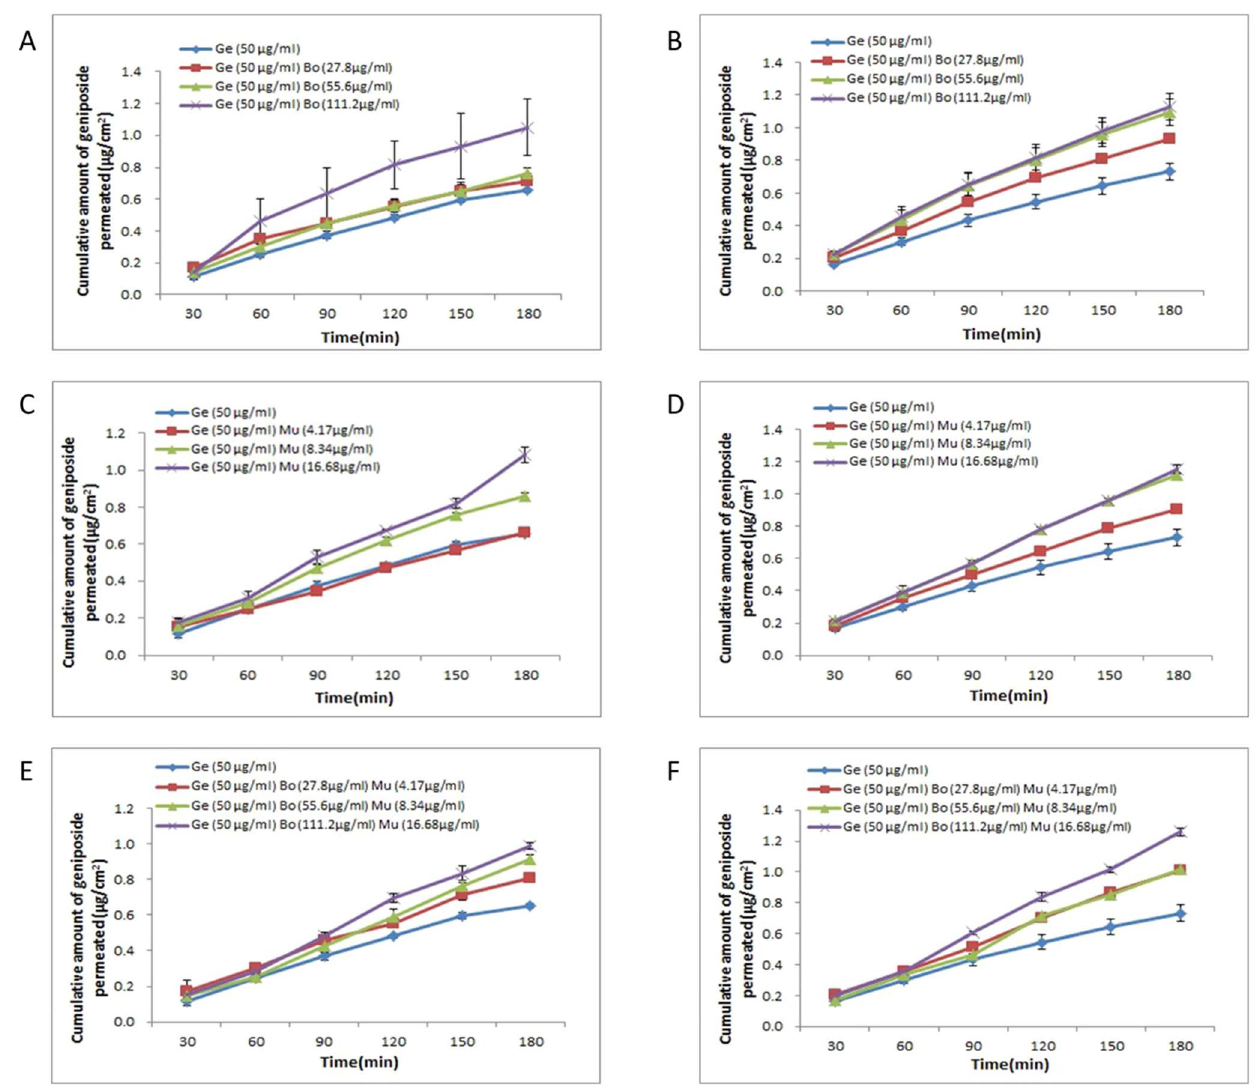
Figure 2. Effects of borneol (Bo) and muscone (Mu) on geniposide (Ge) transport across the HNEC monolayer. (A) Geniposide (50 m g ? mL 2 1 ) combined with borneol A to B transport. (B) Geniposide (50 m g ? mL 2 1 ) combined with borneol B to A transport. (C) Geniposide (50 m g ? mL 2 1 ) combined with muscone A to B transport. (D) Geniposide (50 m g ? mL 2 1 ) combined with muscone B to A transport. (E) Geniposide (50 m g ? mL 2 1 ) combined with borneol and muscone A to B transport. (F) Geniposide (50 m g ? mL 2 1 ) combined with borneol and muscone B to A transport. Date are expressed as mean 6 SD ( n =3).